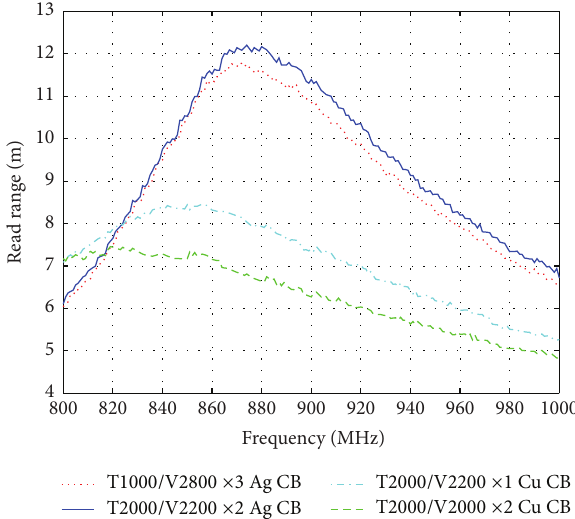
Figure 11: Attainable read ranges of copper and silver tags on cardboard